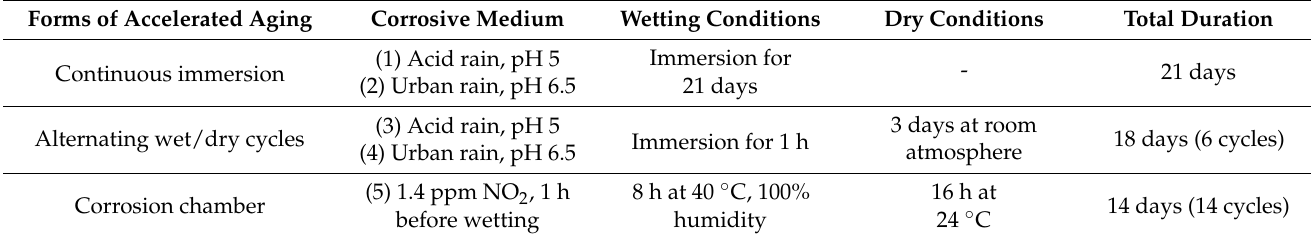
Table 1. Summary of aging conditions for sulphide patinated bronzes. Forms of Accelerated Aging Corrosive Medium Wetting Conditions Dry Conditions Total